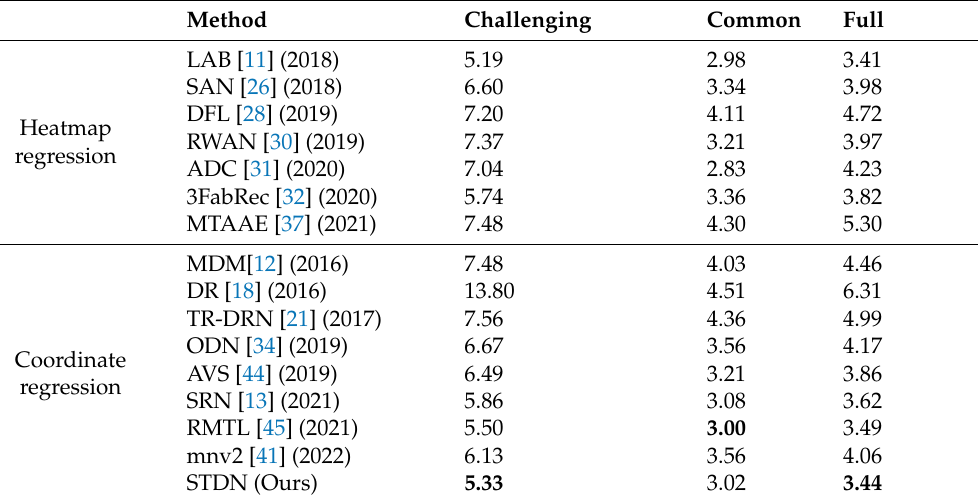
Table 3. NME (in %) of 68-point landmark detection on 300 W.